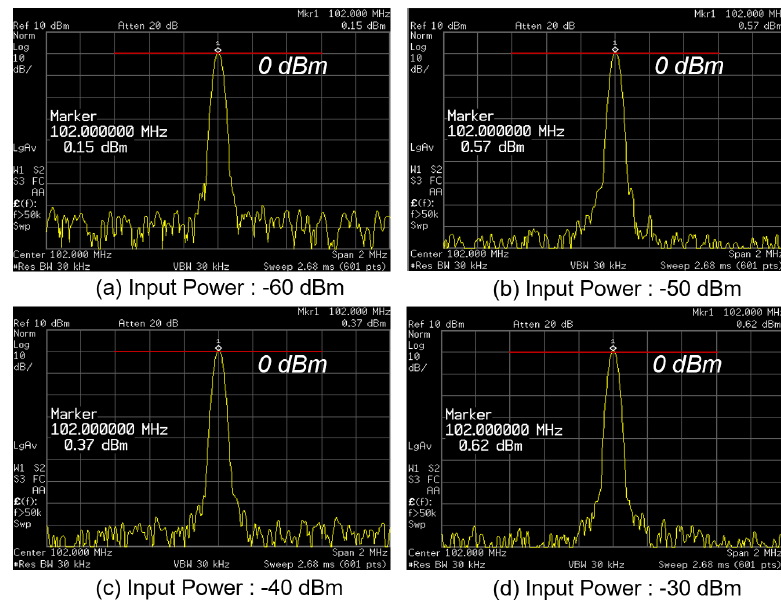
Figure 15. Output FM signals when different input power levels are applied.